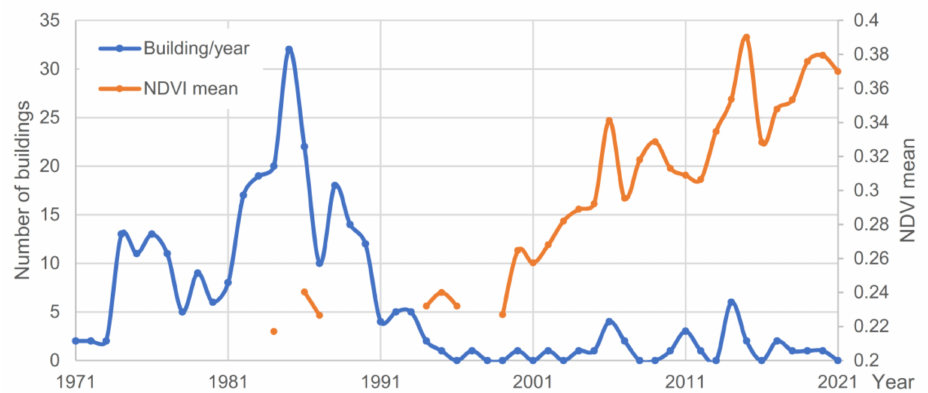
Figure 6. Dynamics of construction of residential buildings in Nadym and dynamics of NDVI within the